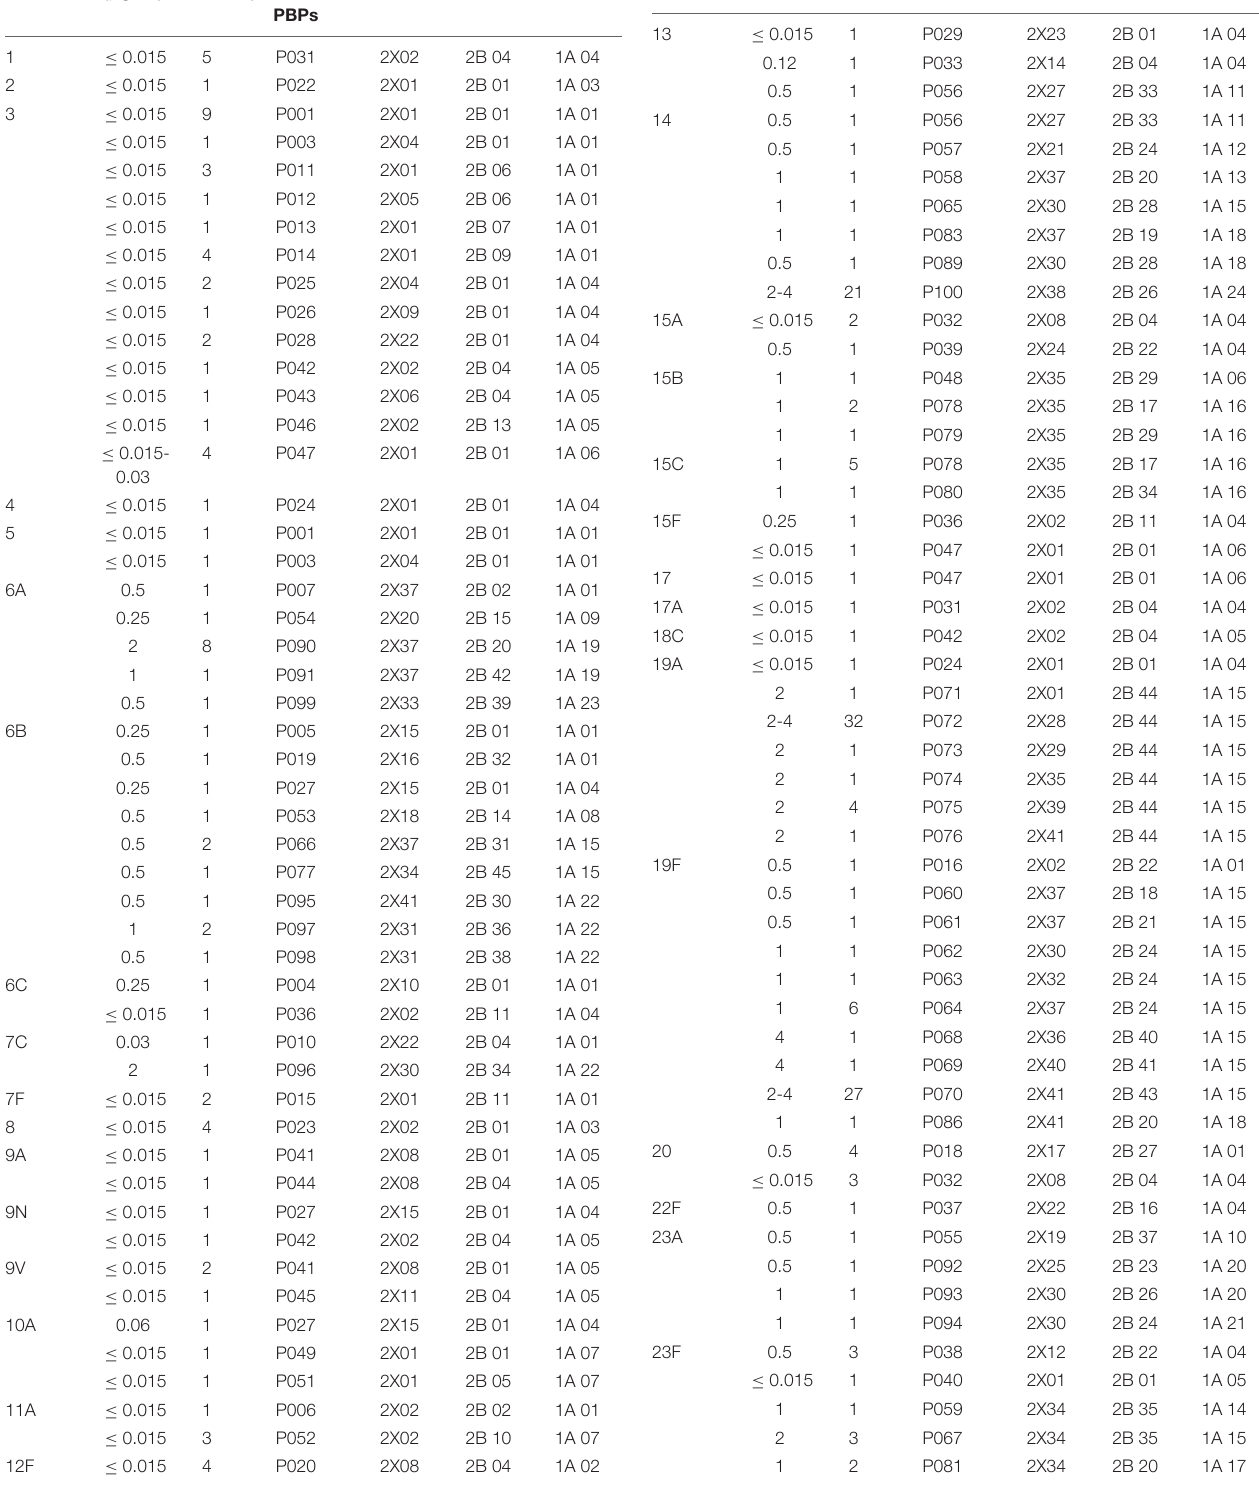
TABLE 10 | Association of serotypes, penicillin susceptibility and substitution patterns of variations in PBP2x, PBP2b and PBP1a in 300 S. pneumoniae isolates.